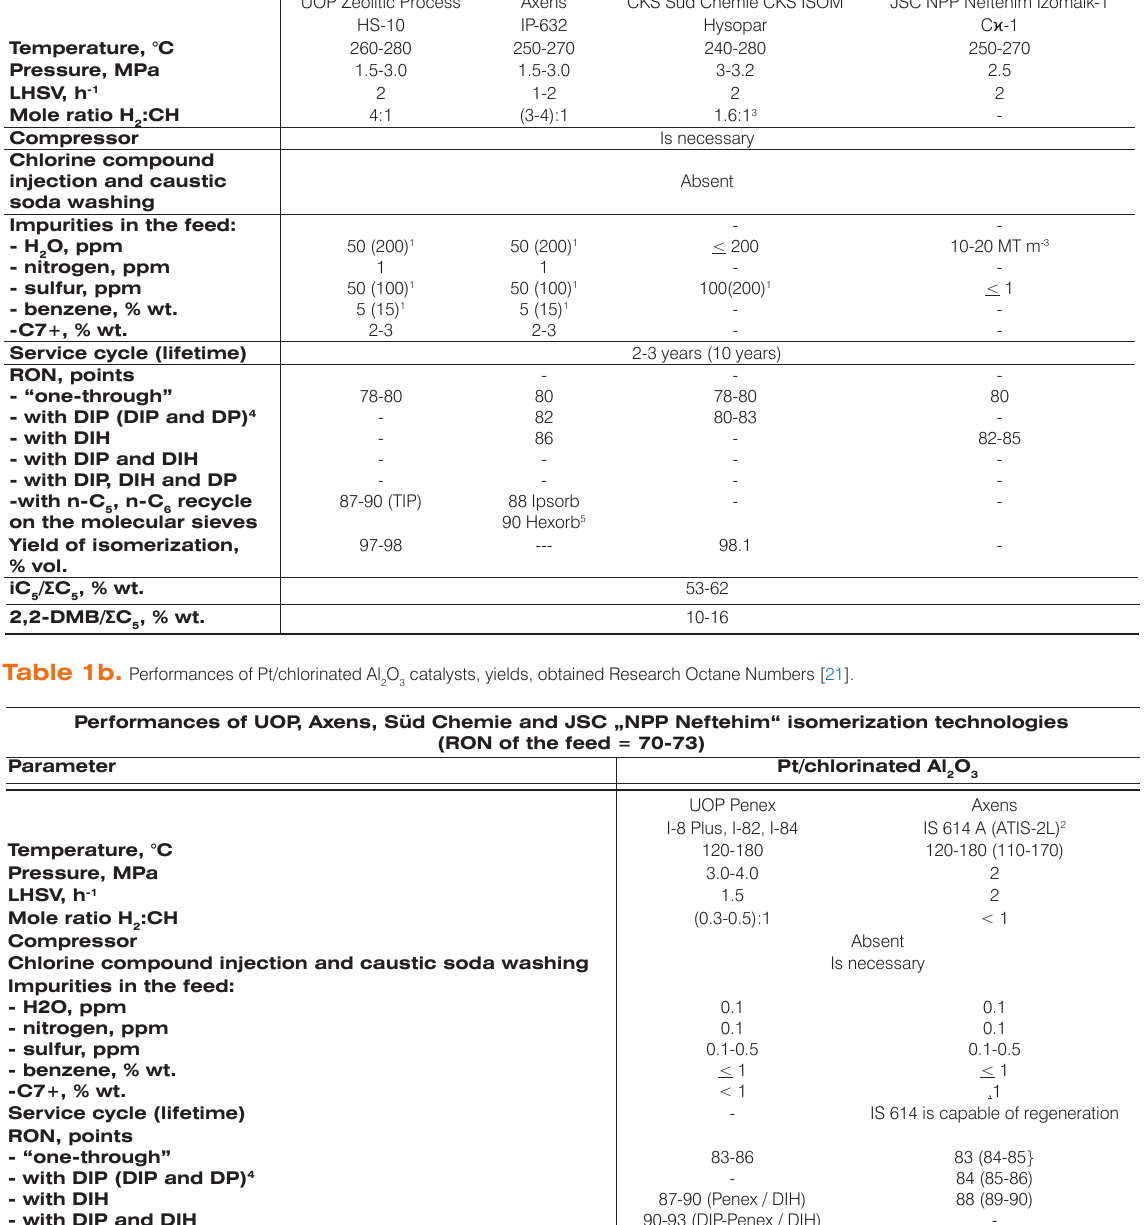
Table 1a. Performances of zeolite catalysts, yields, obtained Research Octane Numbers [21].